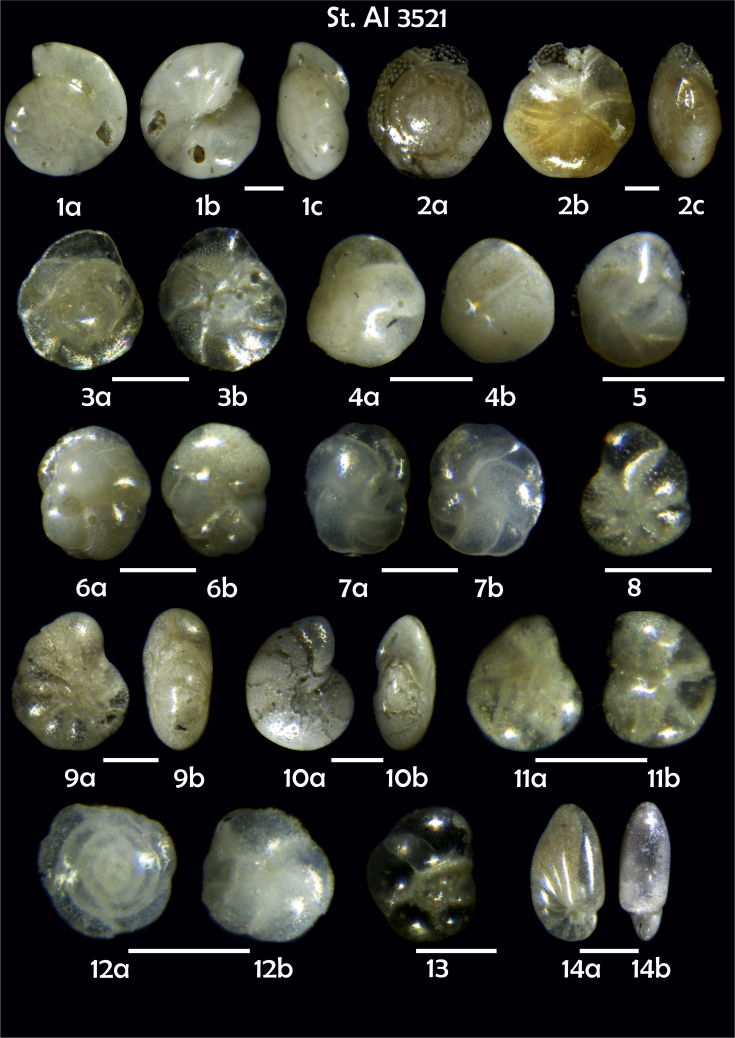
Station 35211Gyroidina orbicularis, a spiral view, b umbilical view, c apertural view. 2Cibicidoides bradyi, a umbilical view, b spiral view, c apertural view. 3Gavelinopsis praegeri,a spiral view, b umbilical view. 4Cassidulina laevigata, a apertural view, b lateral view. 5C. laevigata. 6C. reniforme, a apertural view, b lateral view. 7C. laevigata, a apertutal view, b lateral view. 8Elphidium subarcricum.9E. excavatum?,a side view, b apertural view. 10Melonis? sp. 11Epistominella exigua,a spiral view, b umbilical view. 12Alabaminella weddellensis, a spiral view, b umbilical view. 13Nonionella auricula. 14N. turgida, a lateral view, b aperural view. 15Nonionella sp., a spiral view, b umbilical view. 16N. auricula,a lateral view, b apertutal view. 17Globocassidulina subglobosa. 18Robertinoides sp., a apertural view, b lateral view. 19Pyrgo murrhina.20Triloculina elongata. 21Bolivina earlandi.22Bolivina sp. 23Bolivina sp. 24 Bolivina sp. 25Brizalina subspinescens. 26Bolivina pygmae.27Fursenkoina complanata. 28F. fusiformis. 29Oolina squamosa30Spiroloculina tenuiseptata.31Trifarina angulosa.32Uvigerina peregrina. 33Uvigerina sp. 34Cribrostomoides subglobosus, a side view, b apertural view. 35 ?, a side view, d apertural view. 36Eggerella bradyi. 37Sigmoilopsis schlumbergeri. 38Psammosphaera fusca. 39Lagenammina difflugiformis. Scale 100 μm.